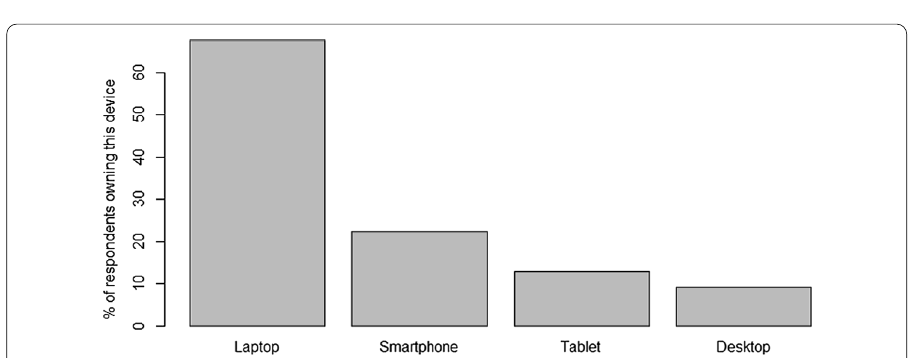
Fig. 3 ICT device ownership among the surveyed students. Note that the total percentages do not sum to 100% as some respondents owned more than one type of